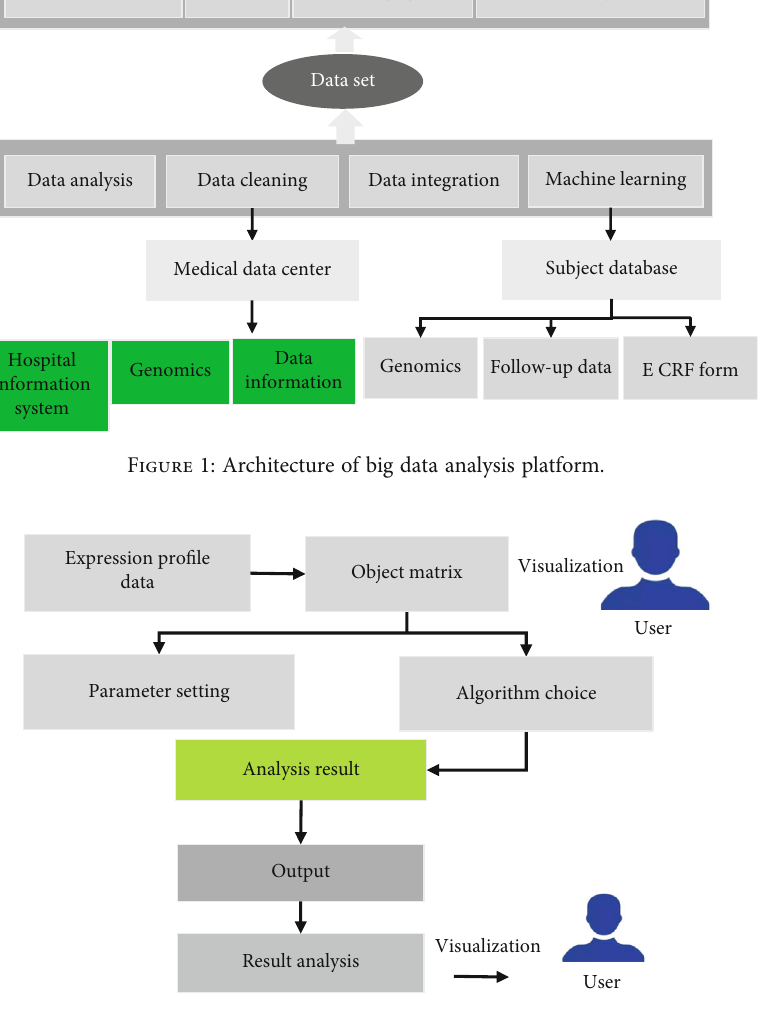
Figure 2: Data process using